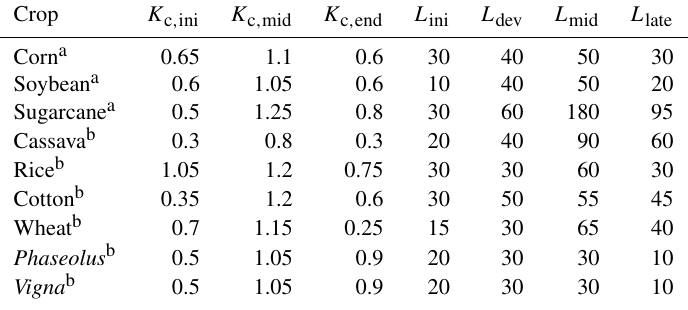
Table A1. Crop coefficients K c (–) and lengths L (d) of crop development stages of the crops considered in this study.